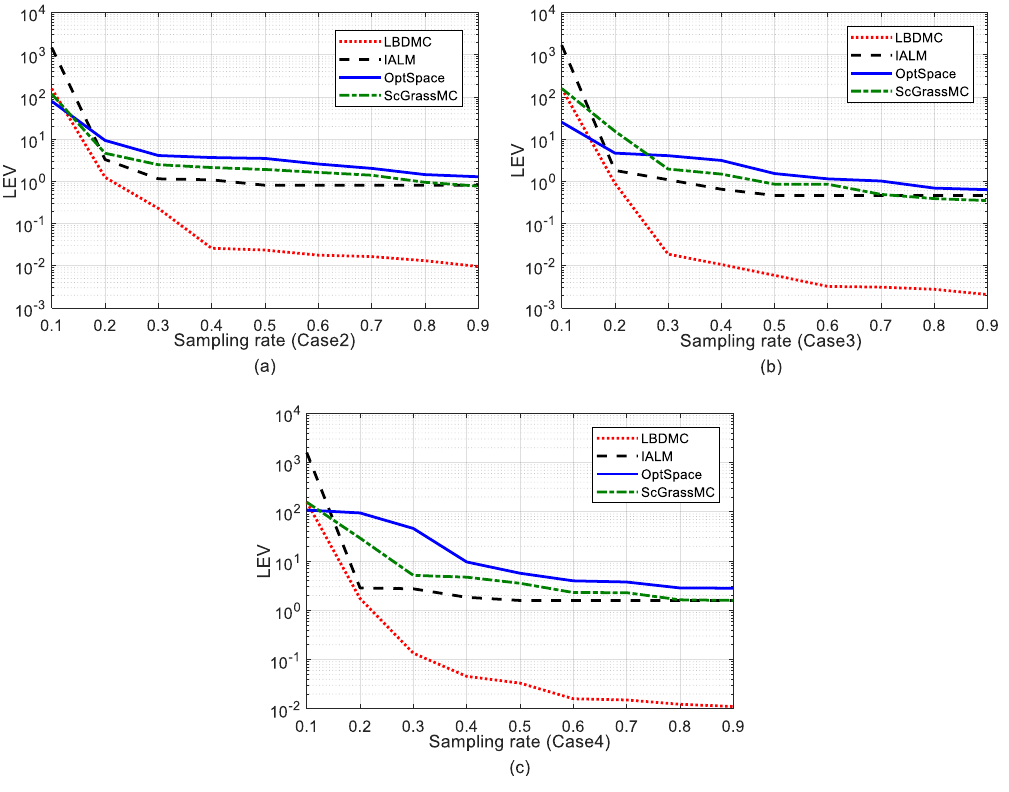
Figure 6. Localization error variance versus different sampling rates. The sampling rate varies successively from 10% to 90%: ( a ) Error variance under Case 2; ( b ) Error variance under Case 3; ( c ) Error variance under Case 4.